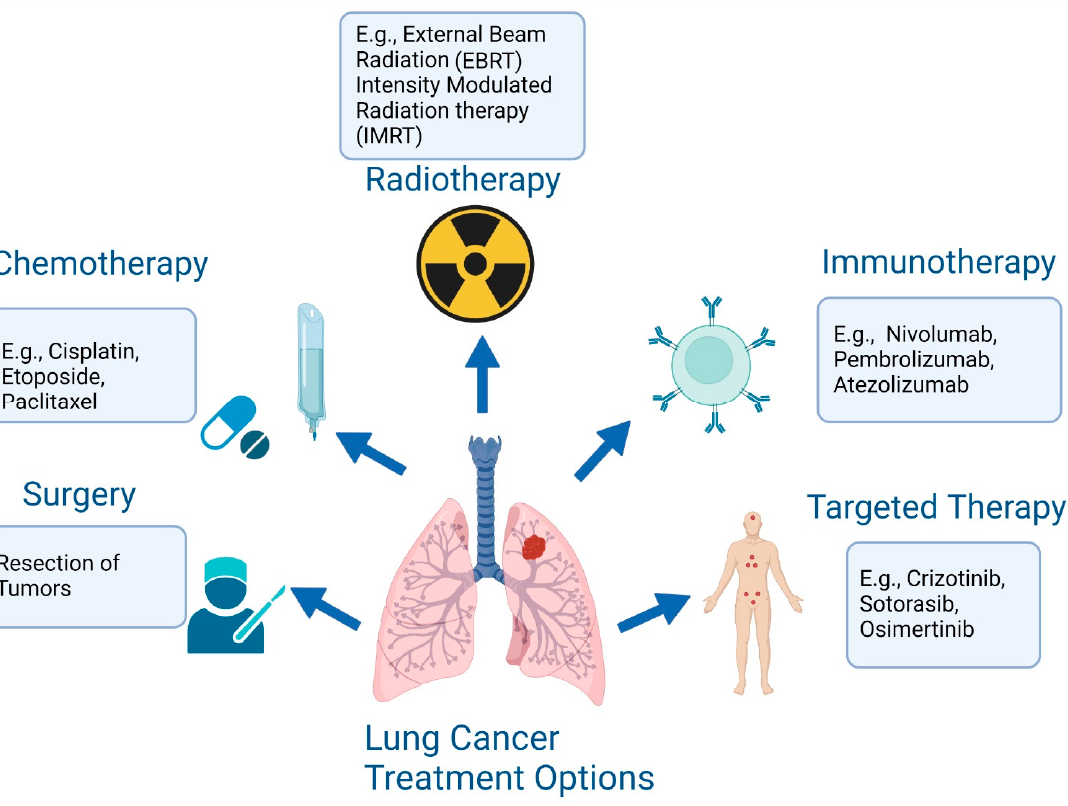
Figure 1. The treatment options for lung cancer are surgery, chemotherapy, radiotherapy, immunotherapy, and targeted therapy (created with BioRender.com (accessed on 1 September 2022).